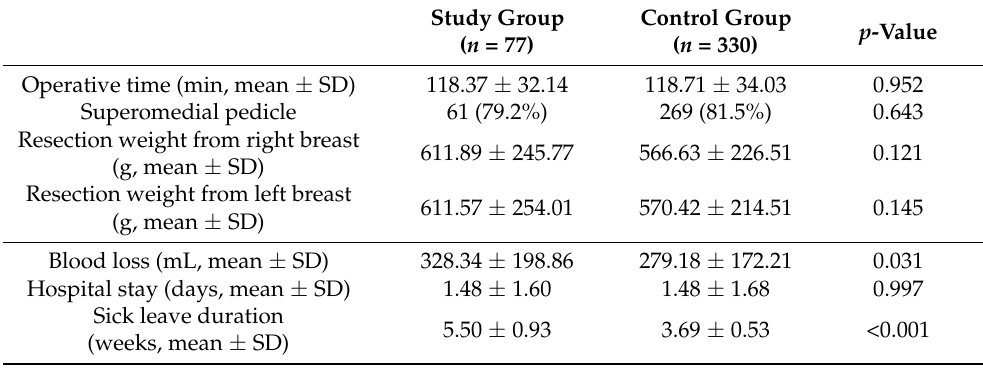
Table 2. Comparison of peri-operative parameters in the two groups of patients. Study group included patients who experience a prolonged sick leave versus the other